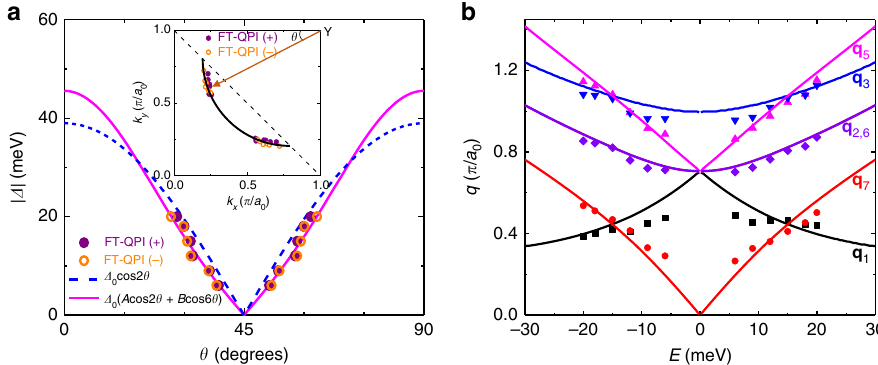
Fig. 4 Energy dispersions for characteristic scattering wave vectors and superconducting gap. a Superconducting gap Δ ( θ ) (circles) and two fi tting curves by different d -wave gap functions. The inset in a shows the positions of the ends of CCE determined by q 1 and q 7 measured at various energies. The solid line shows the Fermi surface from the fi tting to these positions by a circular arc, and it is cut off by the dashed line. The angle θ for each end of CCE is de fi ned in the inset. The gap value Δ for each end of CCE is equivalent to the energy at which the QPI data are measured. b Energy dispersion of the scattering wave vectors taken from the FT-QPI data (excluding q 4 due to very weak intensity). The solid lines represent the theoretical predictions based on the Fermi surface and the d -wave gap function with high order shown by the line with magenta color in